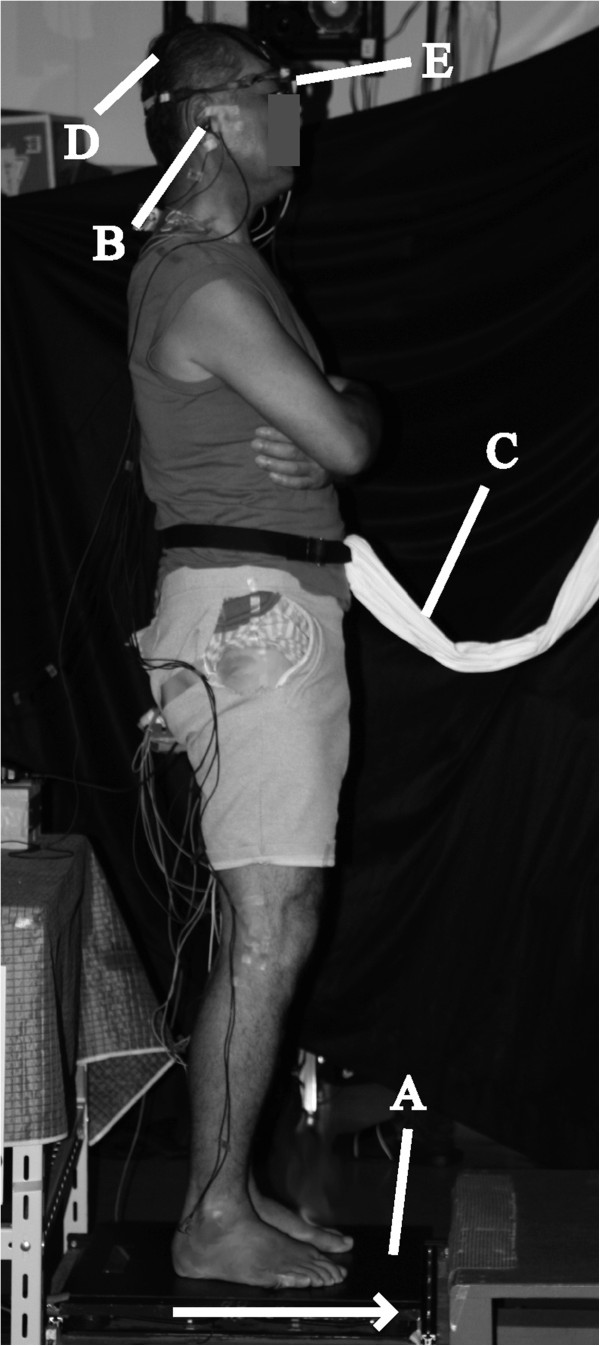
Experimental setup. (A) Platform; (B) Earphone; (C) Harness; (D) Ag-AgCl cup electrodes; (E) Eye-trek face-mounted display. Direction of platform movement is indicated by an arrow.